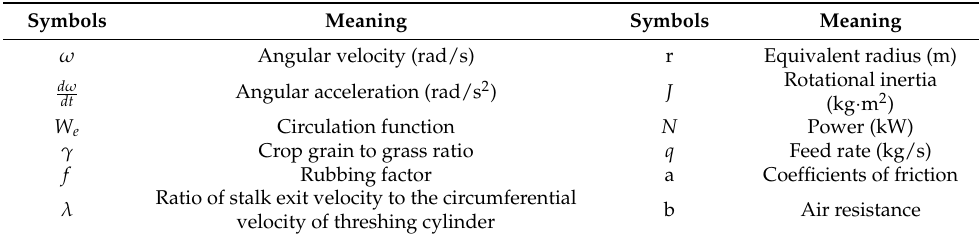
Table 1. Equation symbol table.